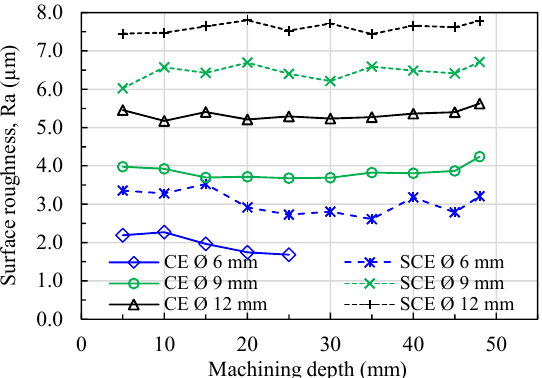
Figure 9. Roughness of the machined surface along the depth of the drilled hole.